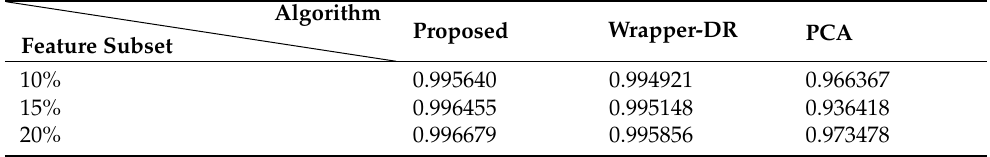
Table 4. Results of